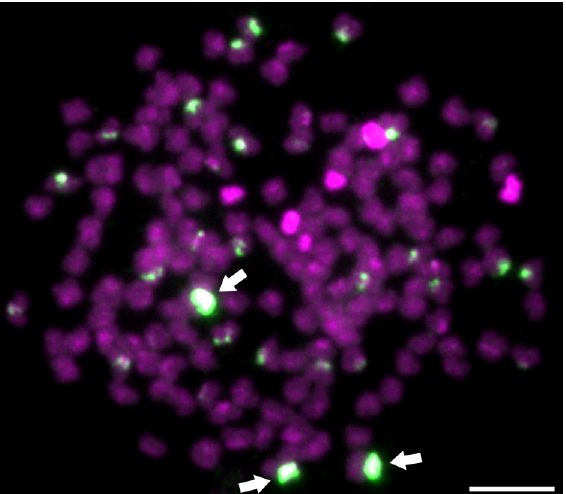
Figure 1. Fluorescent in situ hybridization (FISH) with 5S ribosomal probes on Carassius hybrid female with 156 chromosomes. Three highly intensive 5S gene loci in green (arrowheads) out of twenty-seven show triploid origin of this female. Chromosomes are counterstained with 4’,6- diamidino-2-phenylindole (DAPI) in blue and red. Scale bar represents 10 µ m. Figure was modified according to Knytl et al.